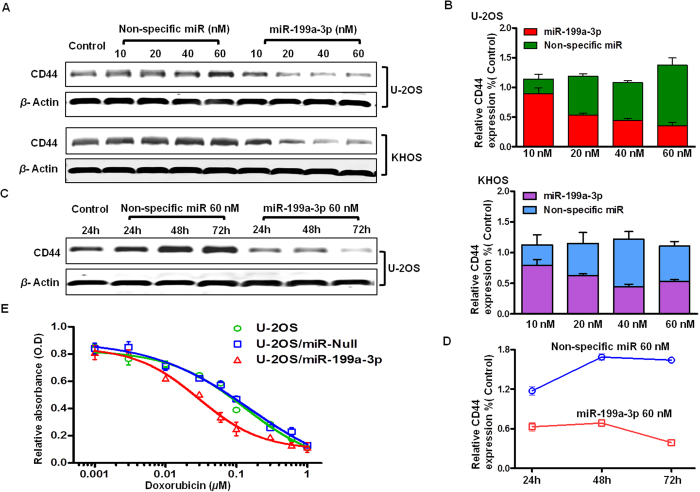
The dose and time dependent effect of miR-199a-3p on knocking down CD44 and increasing the doxorubicin sensitivity of osteosarcoma.A and B miR-199a-3p knocked down CD44 in osteosarcoma cells as a dose dependent manner. C and D miR-199a-3p knocked down CD44 in osteosarcoma cells as a time dependent manner. E MTT assay showing cell viability of U-2OS, U-2OS/miR-null, and U-2OS/miR-199a-3p after incubating with different concentrations of doxorubicin.